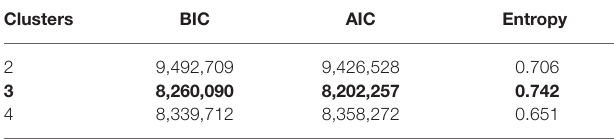
TABLE 3 | The fit of the all latent class